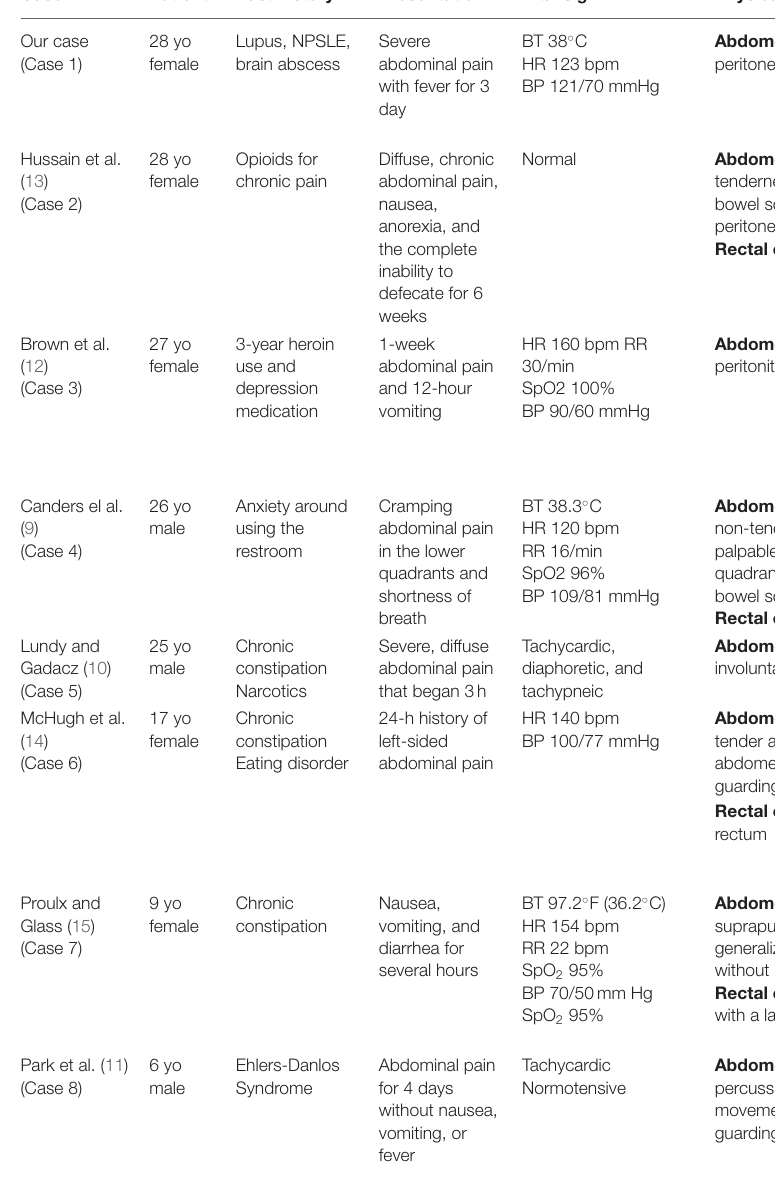
TABLE 1 | Comparison of our patient with published data on stercoral colitis or perforation at young ages.